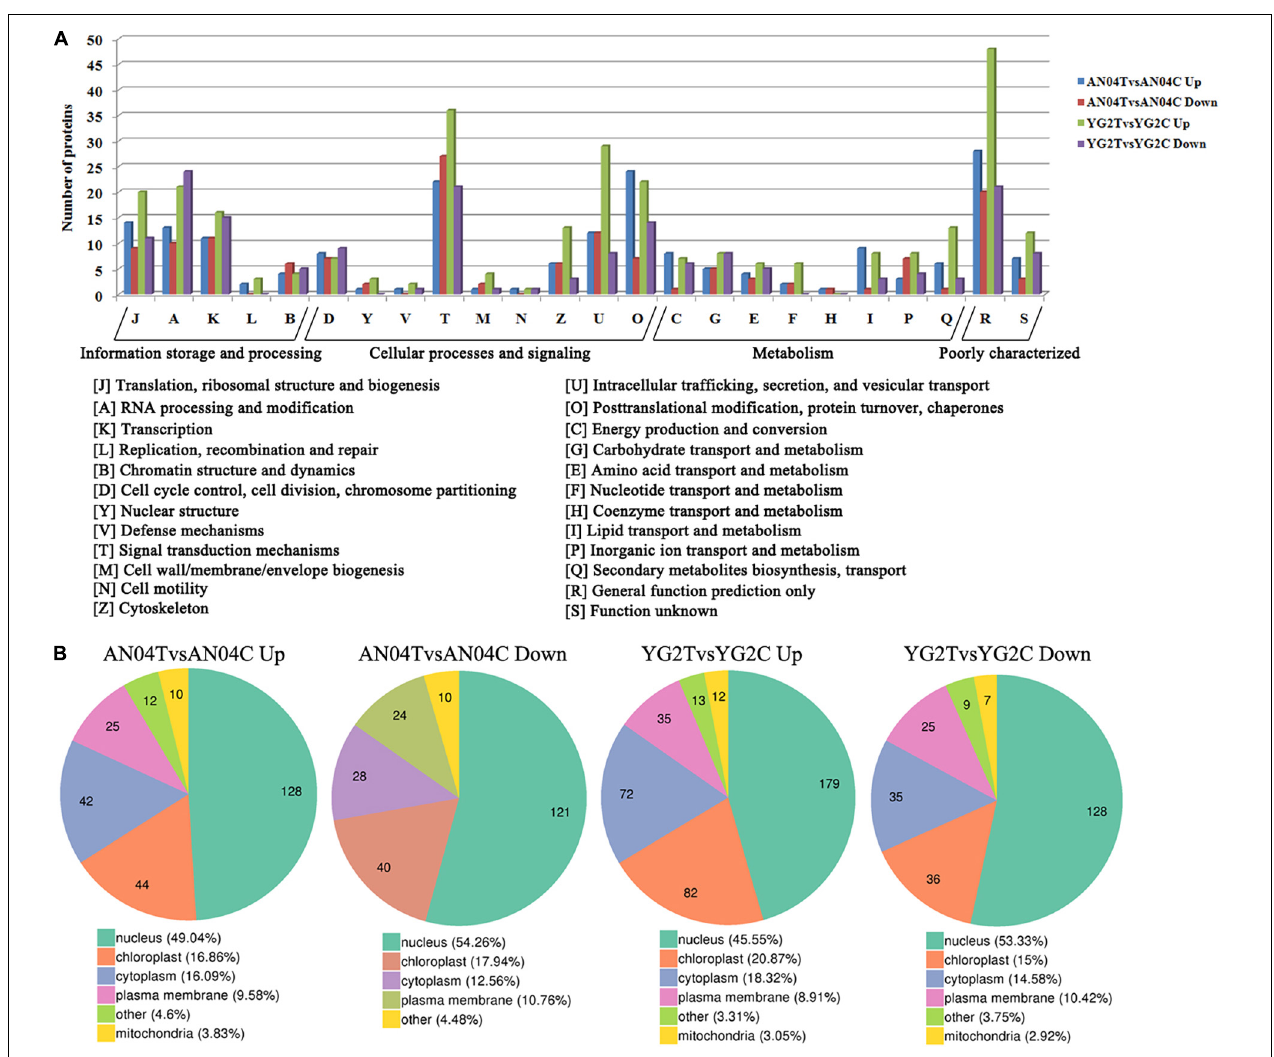
FIGURE 3 | (A) The clusters of orthologous groups of proteins (KOG/COG) classification of the DRPPs in Yugu2 and An04 after salt stress. (B) The subcellular localization of DRPPs in Yugu2 and An04 after salt